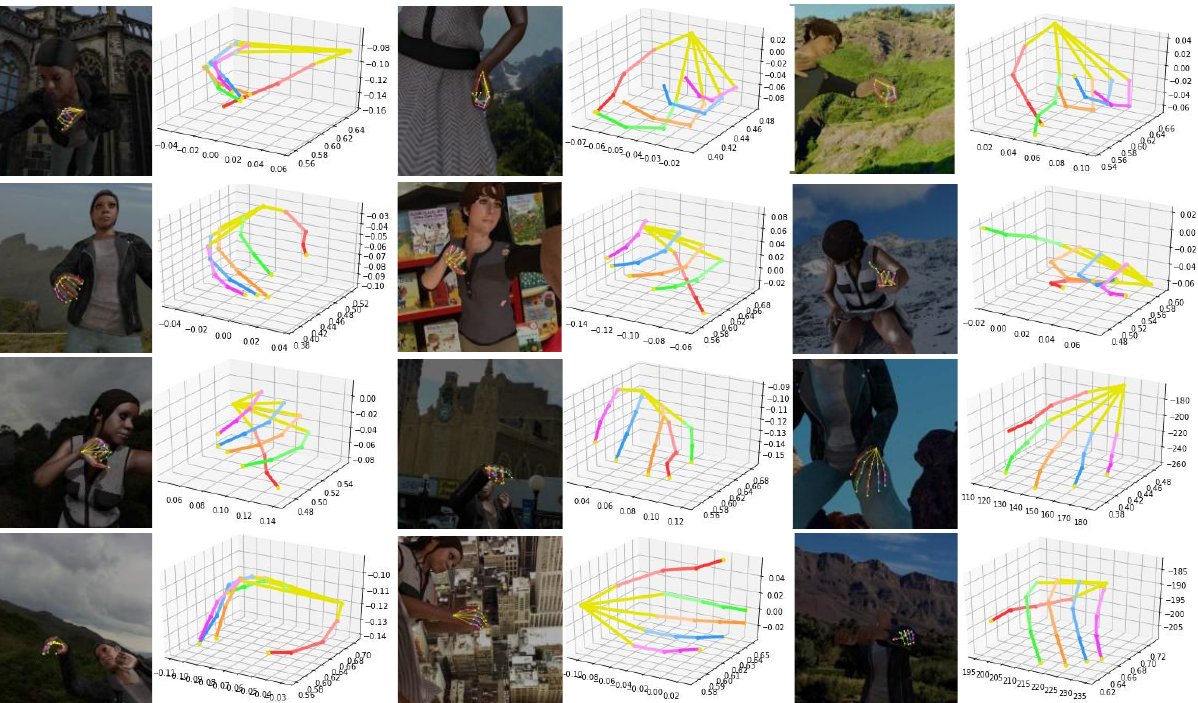
Figure 6. Some examples of our 2D and 3D results. The first, third, and fifth columns show the results of the 2D hand pose estimation. The second, fourth, and sixth columns show the results of the 3D hand pose